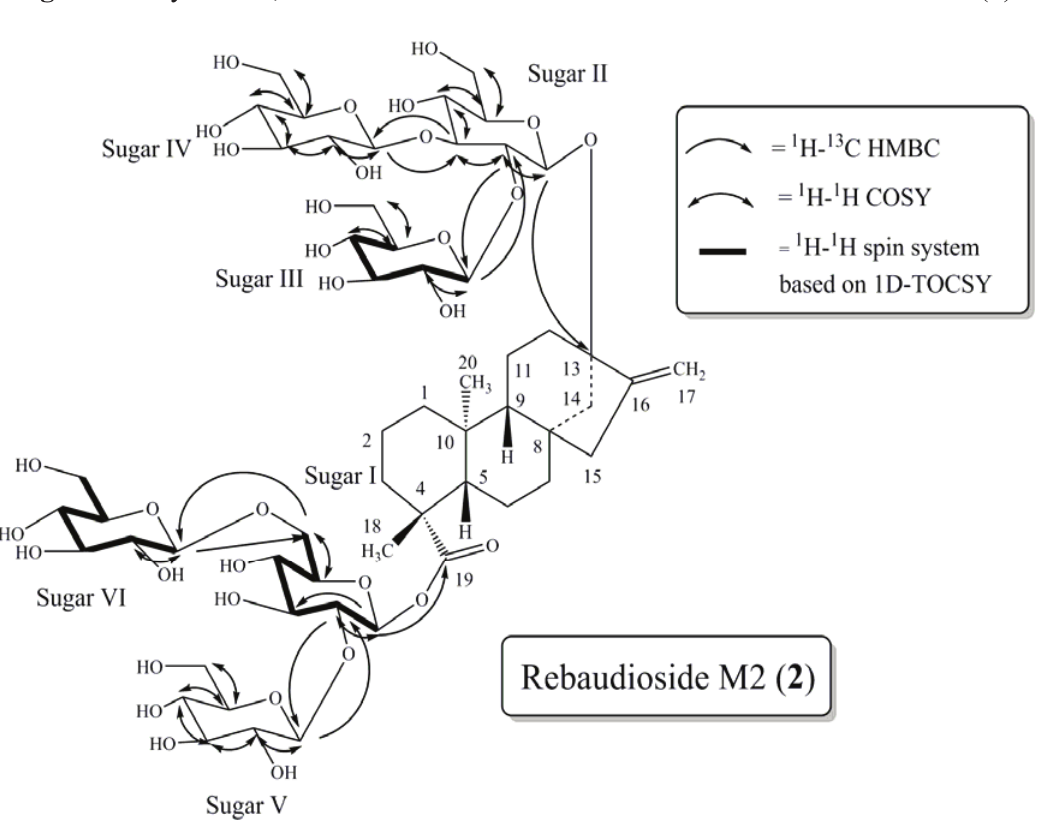
Figure 3. Key COSY, HMBC and 1D-TOCSY correlations of rebaudioside M2 ( 2